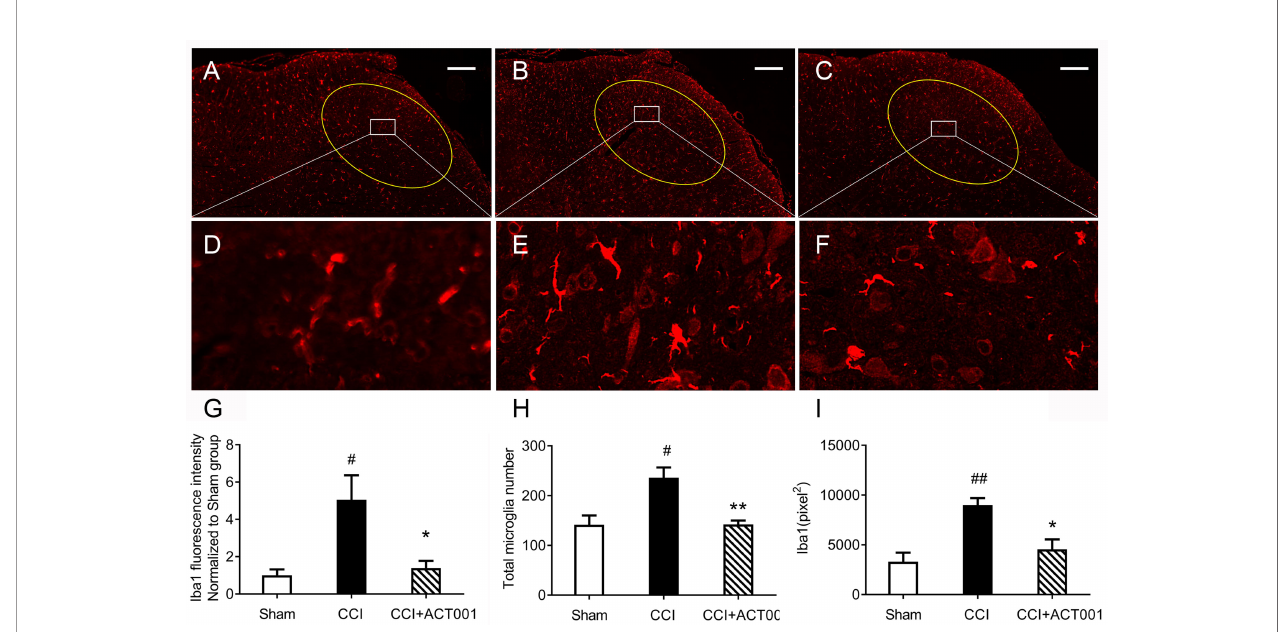
FIGURE 7 | ACT001 inhibits microglial activation markers expression induced by CCI. The lumbar spinal cords (L4-L6) were collected following the fi nal behavioral testing shown in Figure 6 . These tissues were stained for microglial activation markers. (A-C) Representative immuno fl uorescence Iba1 images for the sham group (A) , CCI group (B) , and CCI + ACT001 group (C) . (D-F) Representative images for sham group (D) , CCI group (E), and CCI + ACT001 group (F) with high magni fi cation (×60). (G-I) The quanti fi cation of Iba1 expression was shown as normalized fl uorescence intensity (G) , number (H) , and size of (I) microglia. Scale bar = 200 m m. All the data represented mean ± SEM. # P< 0.05, ## P< 0.01 versus the sham group; *P< 0.05, **P< 0.01 versus the CCI